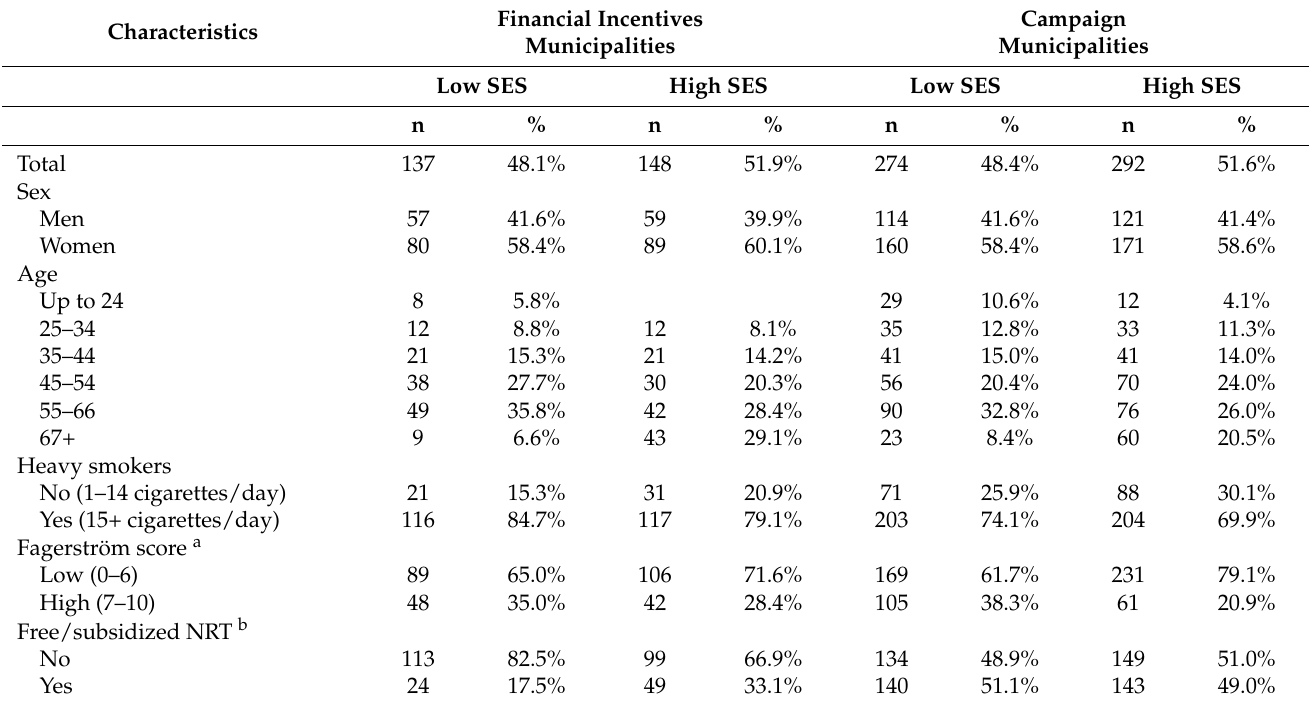
Table 1. Baseline characteristics of smokers with high and low socioeconomic status (SES) included in the community-randomized trial “Richer without smoking”,